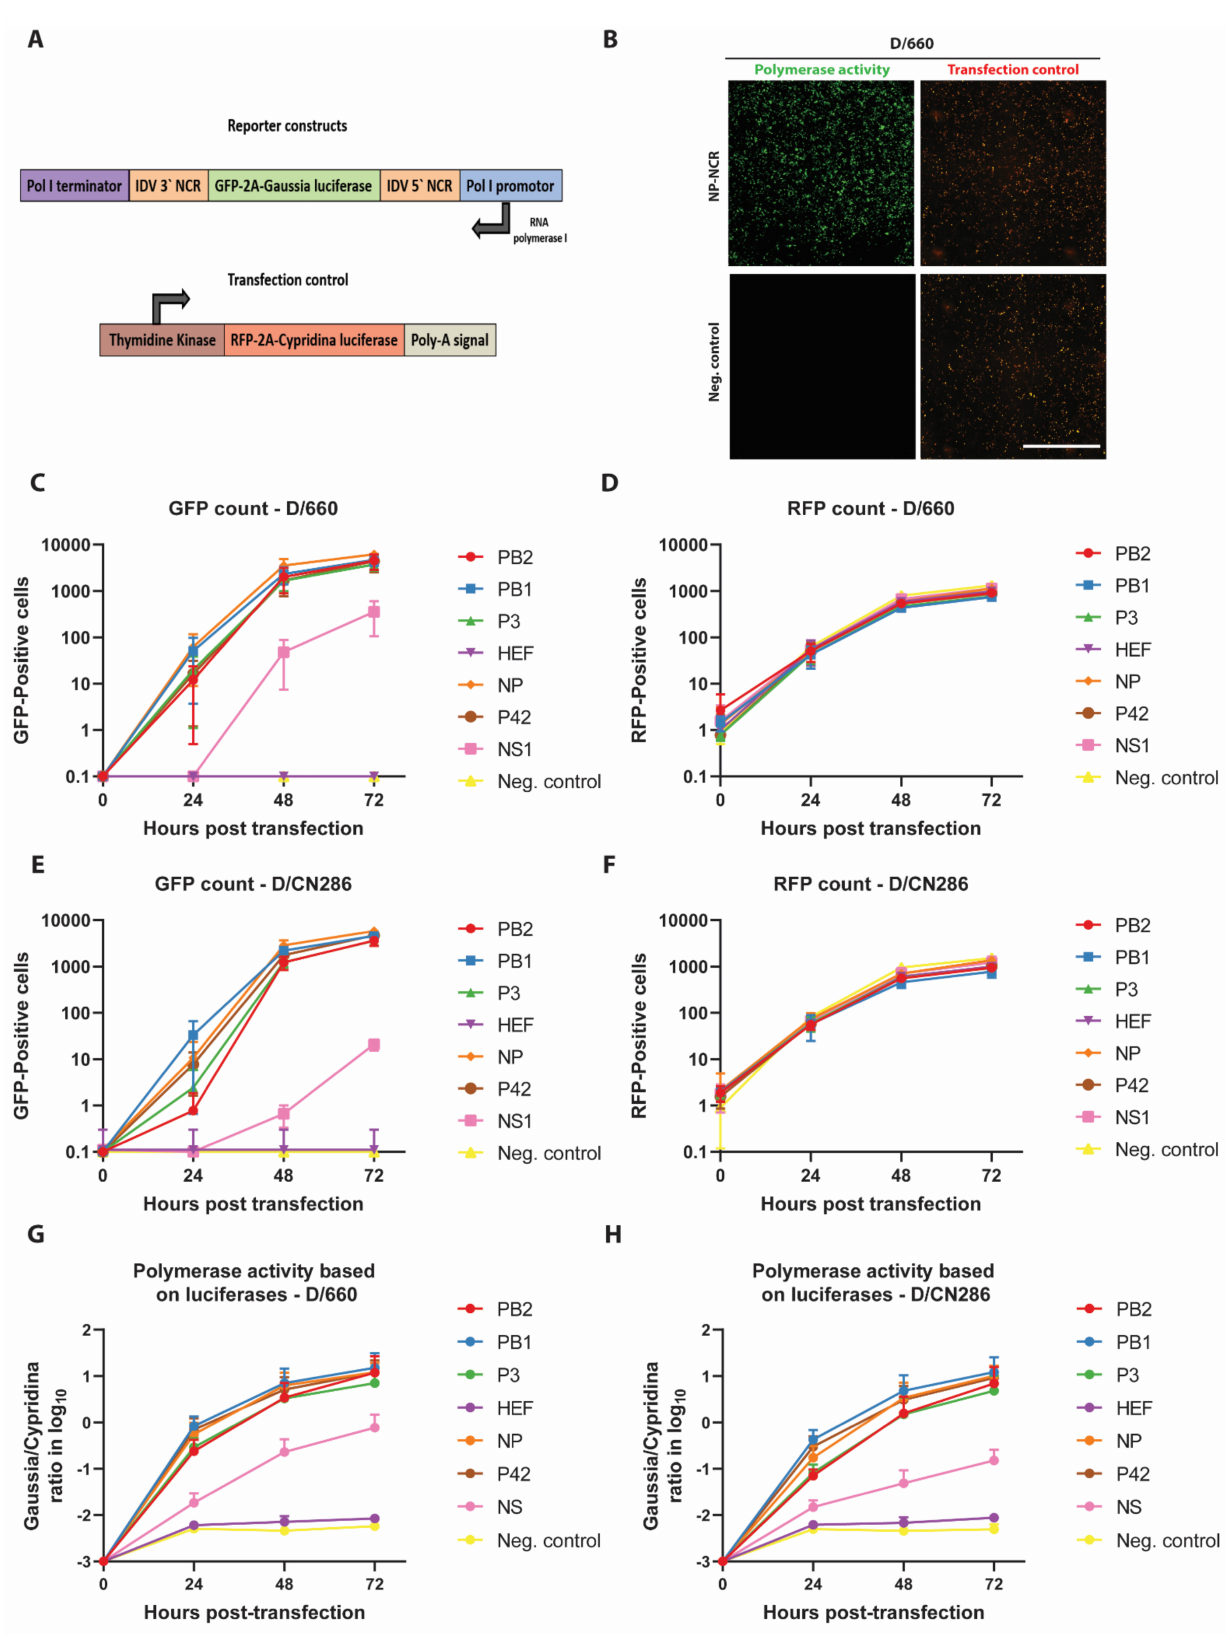
Figure 2. Analysis of the functionality of each segment-specific non-coding region (NCR) of Influenza D virus (IDV) by polymerase reconstitution assay (minireplicon). 293-LTV cells were transfected with expression plasmids encoding for